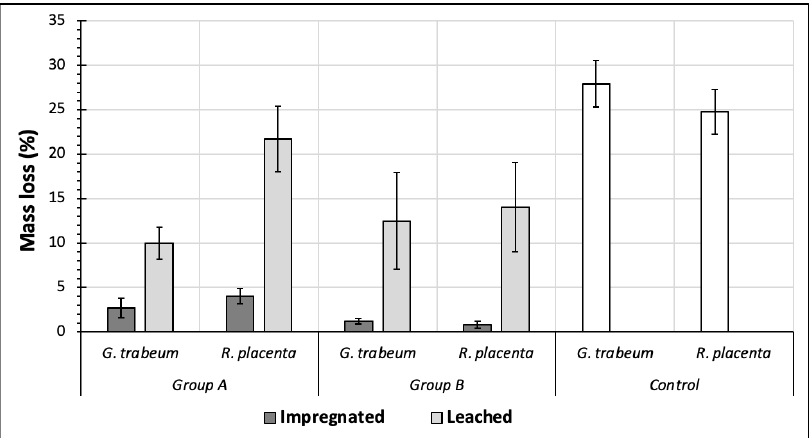
Figure 6. Mass loss, expressed in percent, in impregnated and leached specimens of radiata pine wood treated with CuNP after exposure to Gloeophyllum trabeum and Rhodonia placenta . The maximum standard error for mass loss is 3.6%.